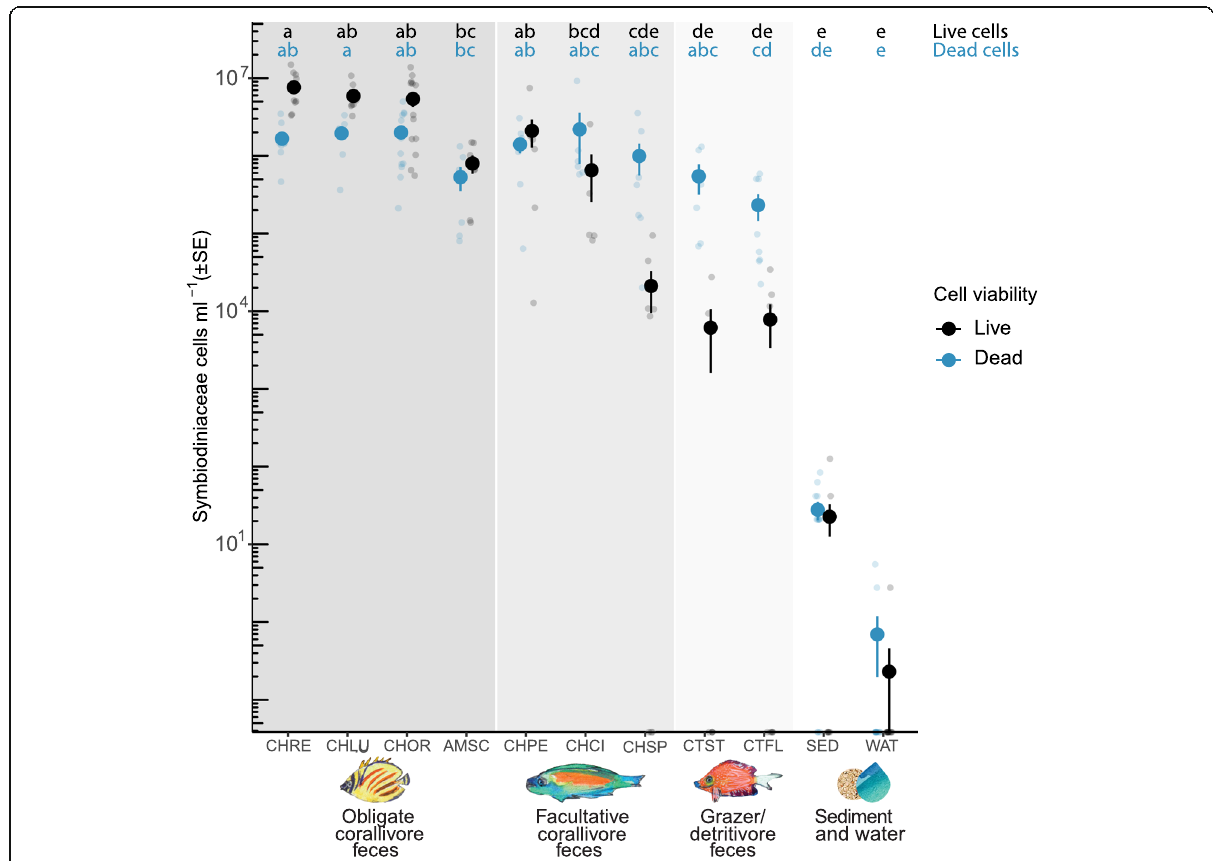
Fig. 2 Feces of obligate corallivores (coral-eating animals) and some facultative corallivores contain live Symbiodiniaceae cells at densities several orders of magnitude higher than the feces of grazer/detritivores, sediment or water samples. Large points indicate the mean live (black) or dead (blue) Symbiodiniaceae cell density of a given species or sample type; vertical lines depict standard errors of the mean (SE). Each small point indicates cell densities quantified from a fecal sample collected from the hind gut of an individual fish ( n = 76 total) or from an individual sediment or water sample ( n = 24 total). Included samples (and sample sizes) for each sample category are as follows: Obligate corallivores (dark shading): Amanses scopas , AMSC (7); Chaetodon lunulatus , CHLU (8); Chaetodon ornatissimus , CHOR (14); Chaetodon reticulatus , CHRE (11). Facultative corallivores (intermediate shading): Chaetodon pelewensis , CHPE (8); Chaetodon citrinellus , CHCI (6); and Chlorurus spilurus CHSP (8). Grazer/Detritivores (light shading): Ctenochaetus flavicauda , CTFL (8); and Ctenochaetus striatus , CTST (6). Sediment and water (no shading): Sediment, SED (12); Water, WAT (12). Significant differences are listed in Table S2. For data used, see Additional file